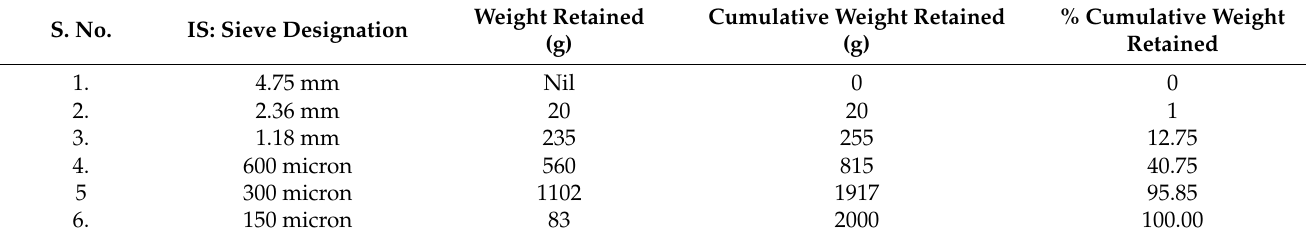
Table 2. Sieve analysis results of fine aggregates